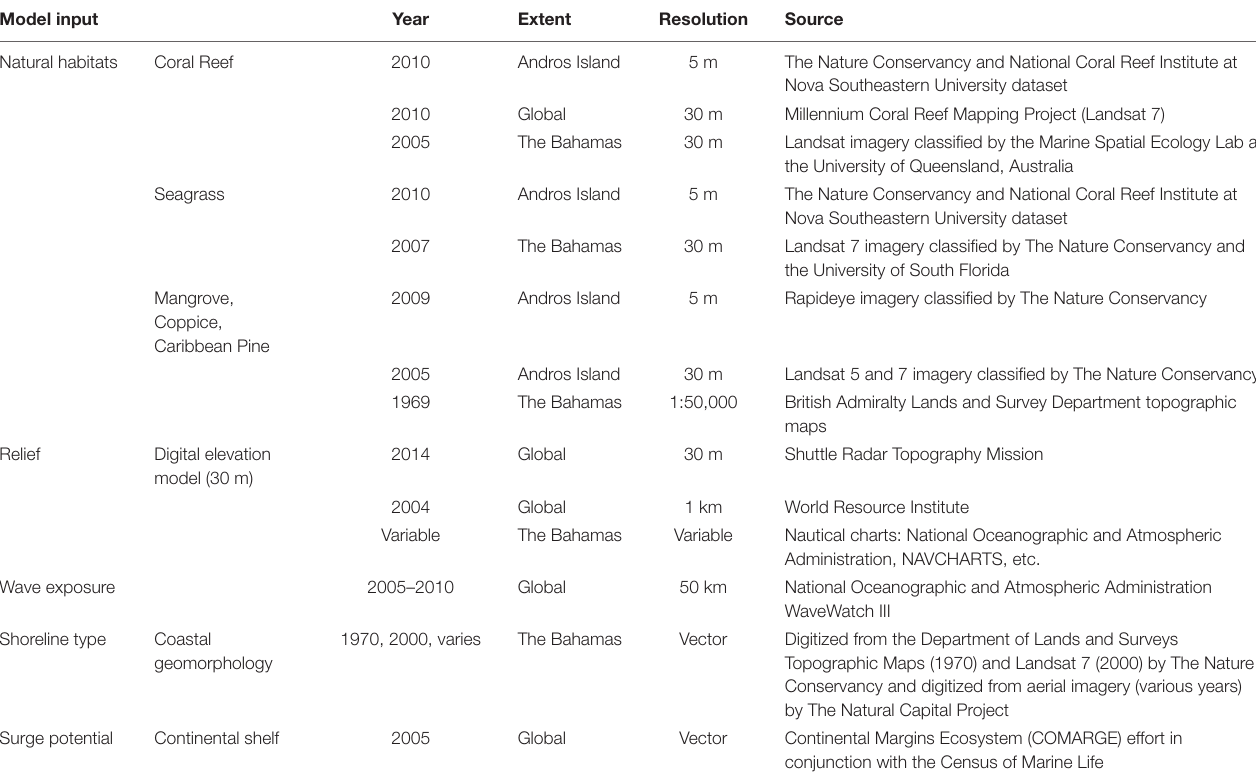
TABLE 2 | Data sources for Coastal Vulnerability model inputs.